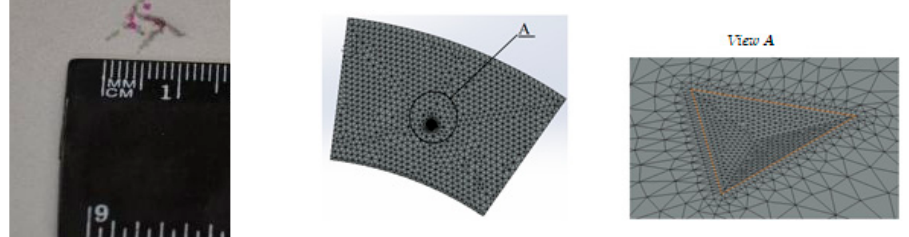
Figure 10. Actual defect and calculation grid for a defect on a disc segment.